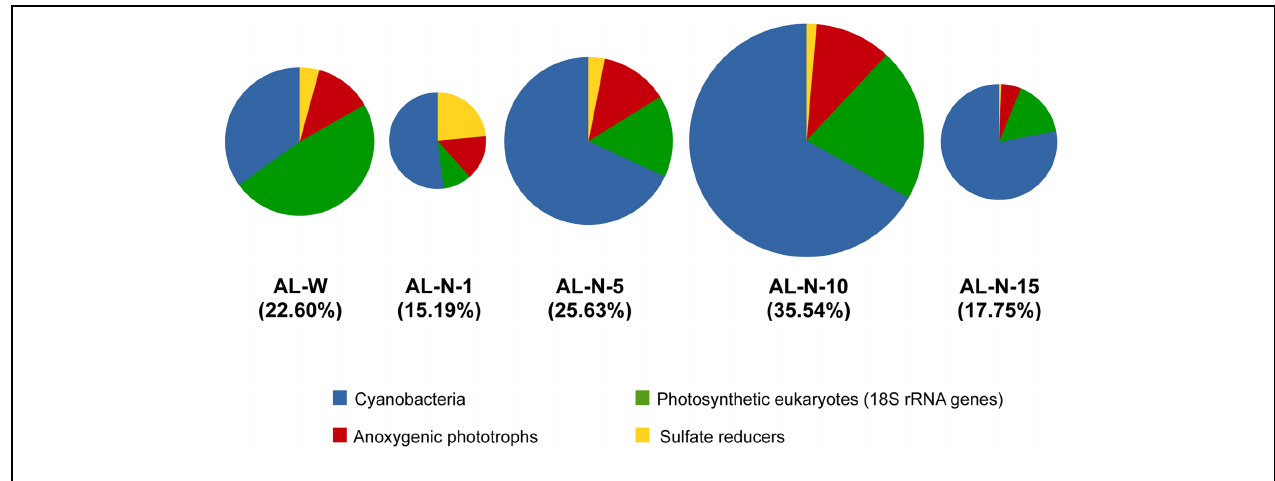
FIGURE 4 | Relative abundance of 16S/18S rRNA gene sequences affiliated to lineages displaying metabolisms favoring carbonate precipitation in Alchichica microbialites. Sizes of pie charts (and the values within brackets) indicate the total proportion represented by these